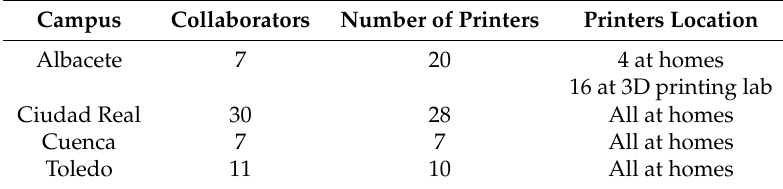
Table 1. Distribution of human and material resources at the University of Castilla-La Mancha (UCLM).